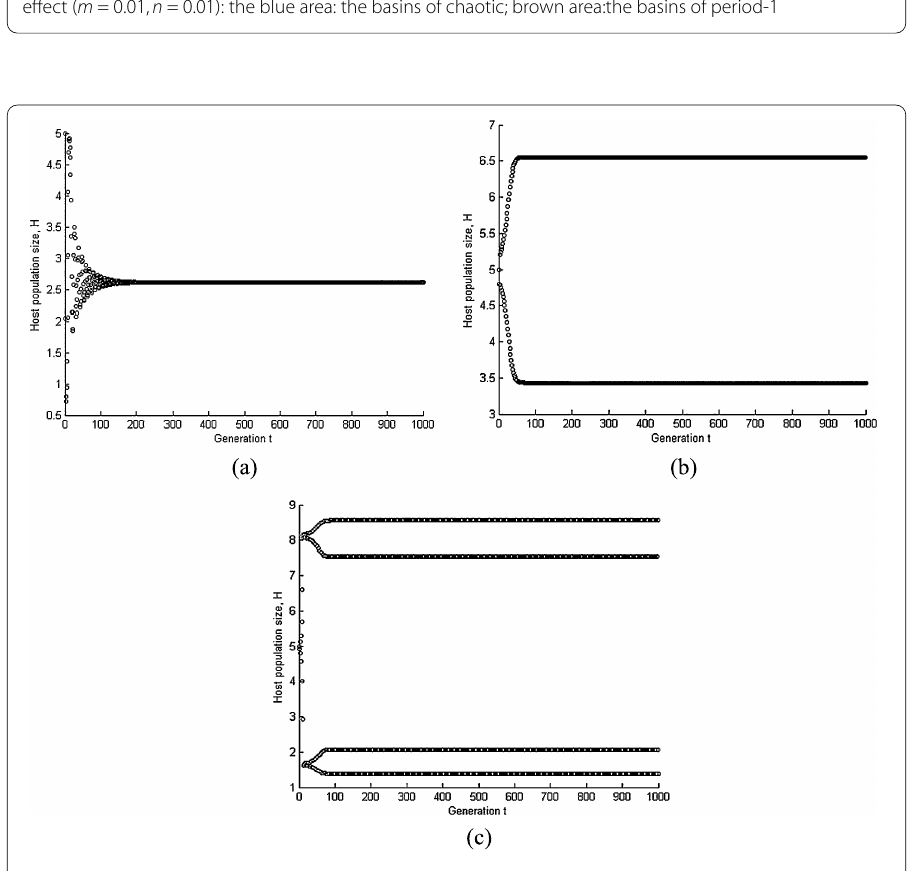
Figure 5 Changes of the host population size over time. We fix T = 1, T n = 0.4, K = 5, and: ( a ) r = 1, b = 0.5, c = 0.2, m = 1, n = 0.005; ( b ) m = 0.01, n = 0.05, r = 2.1, c = 0.2, b = 0.00697; ( c ) n = 0.05, r = 2.6, c = 0.8, b = 0.00697, m =